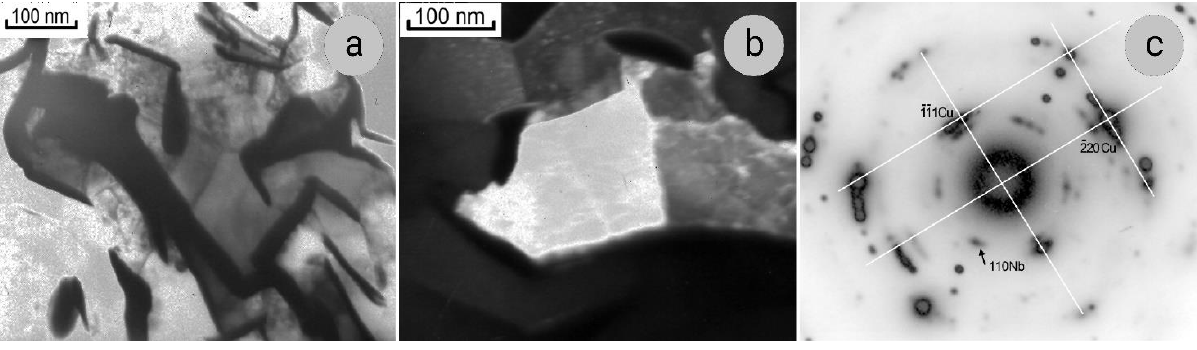
Figure 3. Microstructure of transverse ( a – c ) and longitudinal ( d – f ) sections of Cu – 18Nb composite, Sample 2: ( a , d ) — bright-field images; ( b ) — SAED; ( с ) — dark-field image in (220) Cu reflection; ( e ) — dark-field image in (110) Nb and (111) Cu reflections; f- SAED, zone axes [110]Nb and [111]Cu. In lengthwise sections of both samples, alternating layers of Cu and Nb are seen (Fig- ure 3d,e), the dislocation density in Nb filaments being significantly higher than in the Cu. The < 110 > Nb and < 111 > Cu directions are in line with the drawing direction, with a misorientation of 2 – 5° relative to each other (Figure 3f). The same orientation relationships between these directions were found in Cu – Nb composites obtained by bundle-and-de- form and melt-and-deform (in situ) methods in [37,38]. If, under wire drawing, the Cu matrix and Nb filaments were independently rearranged so that their close-packed planes, (111) Cu and (110) Nb , were perpendicular to the drawing direction, then there would be no misorientation between them. Therefore, the authors of [37] concluded that there was a certain orientation relationship between the filaments and matrix and that the Nb/Cu interfaces became partially coherent in the process of large plastic deformation.